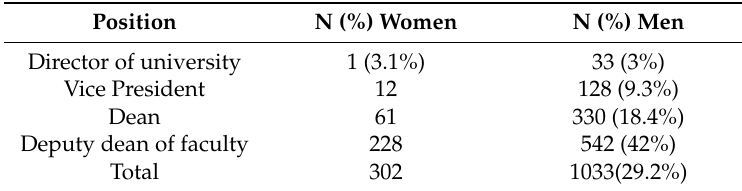
Table 2. Saudi female leaders in higher education (Ministry Of Education 2017) 1